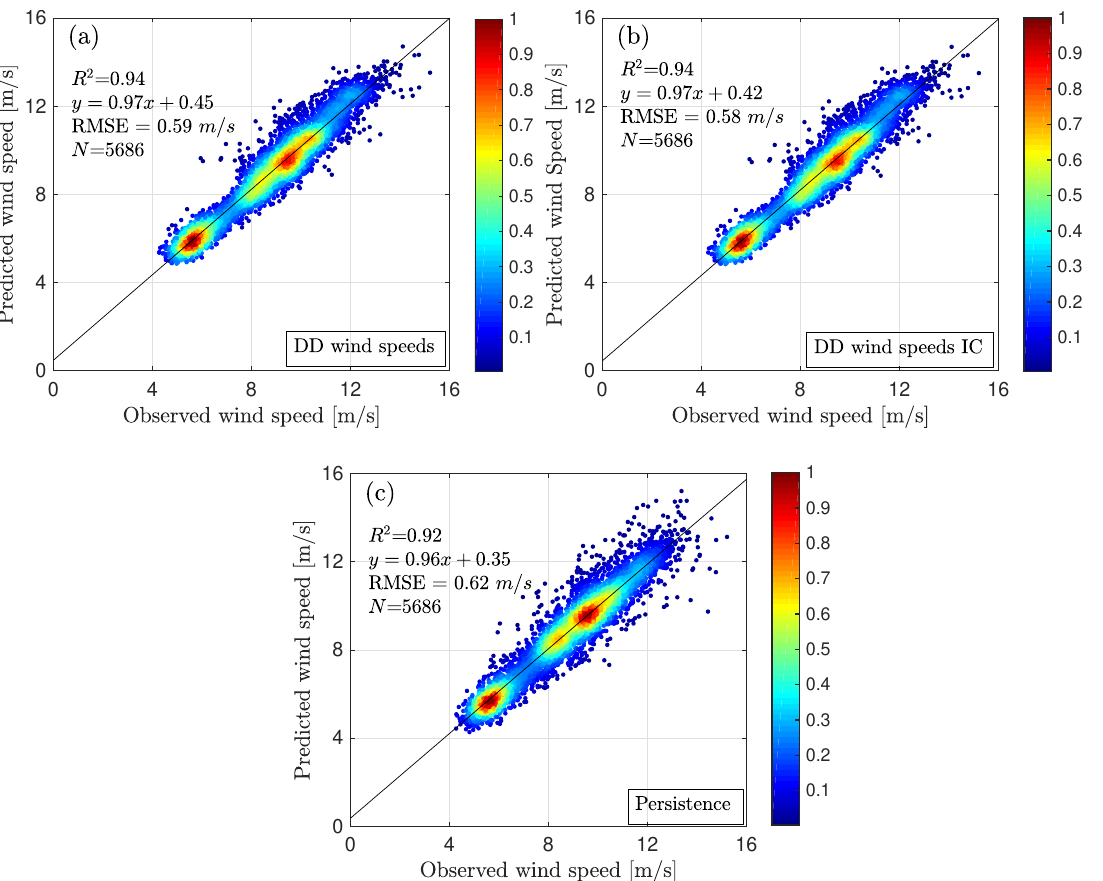
Figure 8. ( a ) density scatter plot of the dual-Doppler wind speeds 2.5 D upstream of the wind turbine rotor (observed wind speed) and the mean of the five-minute ahead wind speeds distributions without velocity correction due to induction effects, ( b ) including the velocity correction due to induction effects and ( c ) for